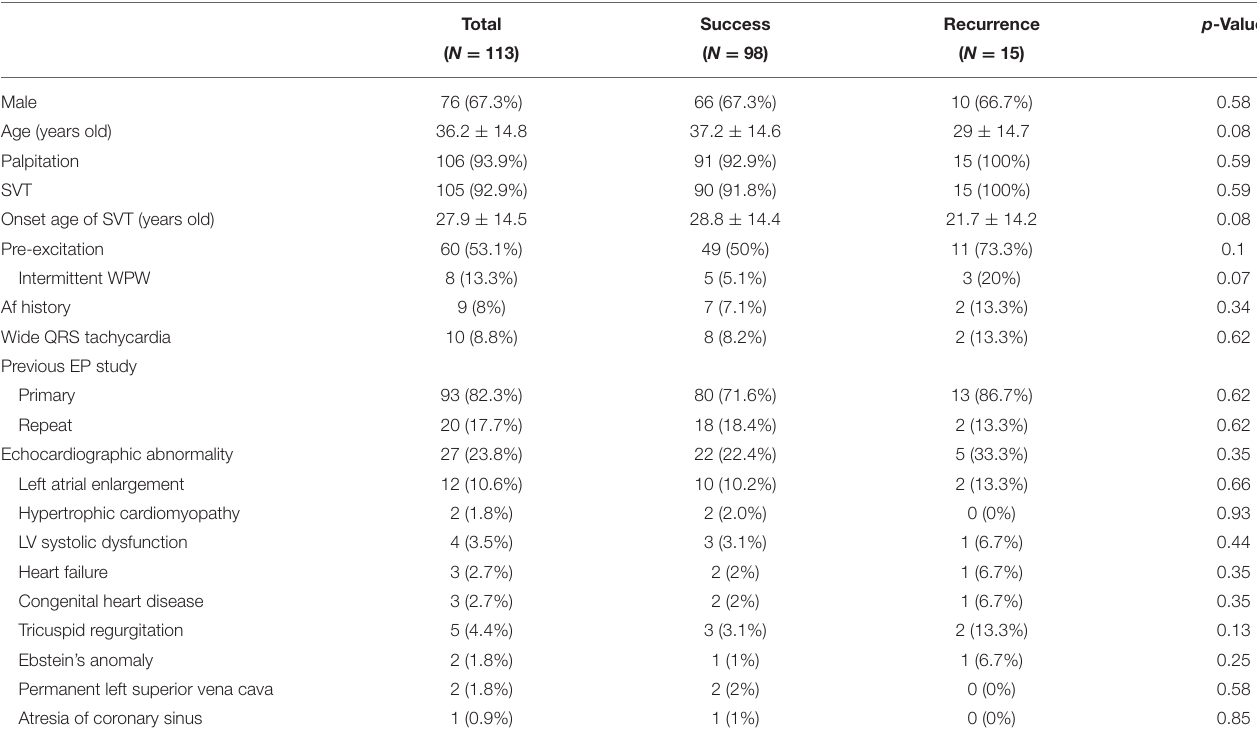
TABLE 1 | Patient demographic